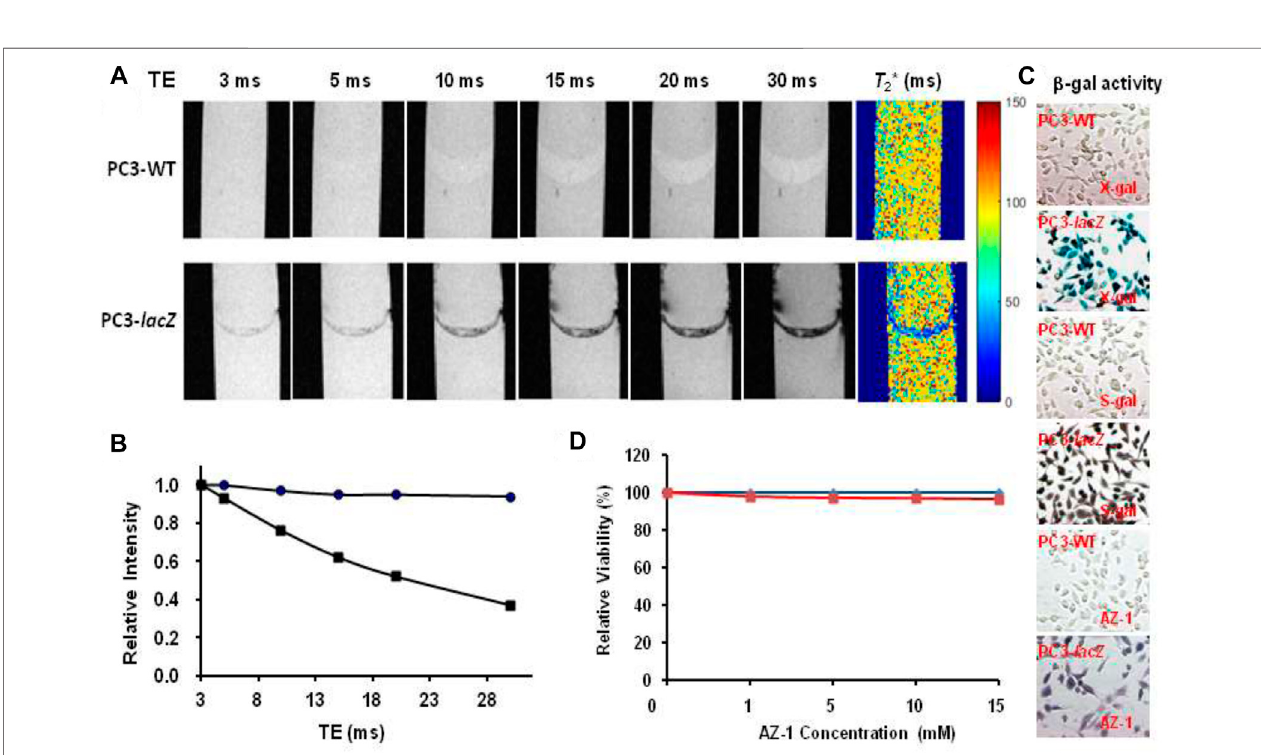
FIGURE 8 | In vitro 1 H-MRI detection of lacZ gene expression in PC3- lacZ cells. 1 H-MRI acquisition: 1 H-MRI, 400 MHz, matrix size: 256 × 128, FOV: 48 mm × 24 mm, gradient echo imaging: TE (cid:1) multiple values 3 – 30 ms, TR (cid:1) 100 ms, fl ip angle (cid:1) 10 ° (A) T 2 * maps: A mixture of alizarin 2- O - β - D -galactopyranosides AZ-1 (10.0 mM)and FAC(10.0 mM)with5 × 10 5 PC3-WTorPC3- lacZ cellswasplacedintheinterlayerbetween1%low-gellingtemperature agarose ina10-mmNMRtube, and then incubated for 4 h at 37 ° C under 5% CO 2 /air with 95% humidity, T 2 * ( AZ-1/PC3-WT/FAC ) (cid:1) 96 ± 23 ms (top row) and T 2 * ( AZ-1/PC3- lacZ /FAC ) (cid:1) 26 ± 14 ms (bottom row), respectively; (B) relative signal intensity changes at different echo times (TEs) from ( A ), essentially no signal loss with PC3-WT cells ( C ) but a signi fi cant signal loss with PC3- lacZ cells ( ■ ); (C) PC3-WT/PC3- lacZ cells staining by X-gal, S-gal, and AZ-1 : deep blue (X-gal), black (S-gal), and dark violet ( AZ-1 ) staining con fi rming an intense lacZ expression in PC3- lacZ cells with essentially no β -gal activity in PC3-WT cells. Regional magni fi cation × 100; (D) cytotoxicity: PC3-WT/PC3- lacZ cells viability vs. AZ-1 in various concentrations in 1:1 (V/V ′ ) DMSO/PBS (0.1 M, pH (cid:1) 7.4) at 37 ° C under 5% CO 2 /air with 95% humidity for 72 h, PC3-WT cells (in blue), and PC3- lacZ cells (in